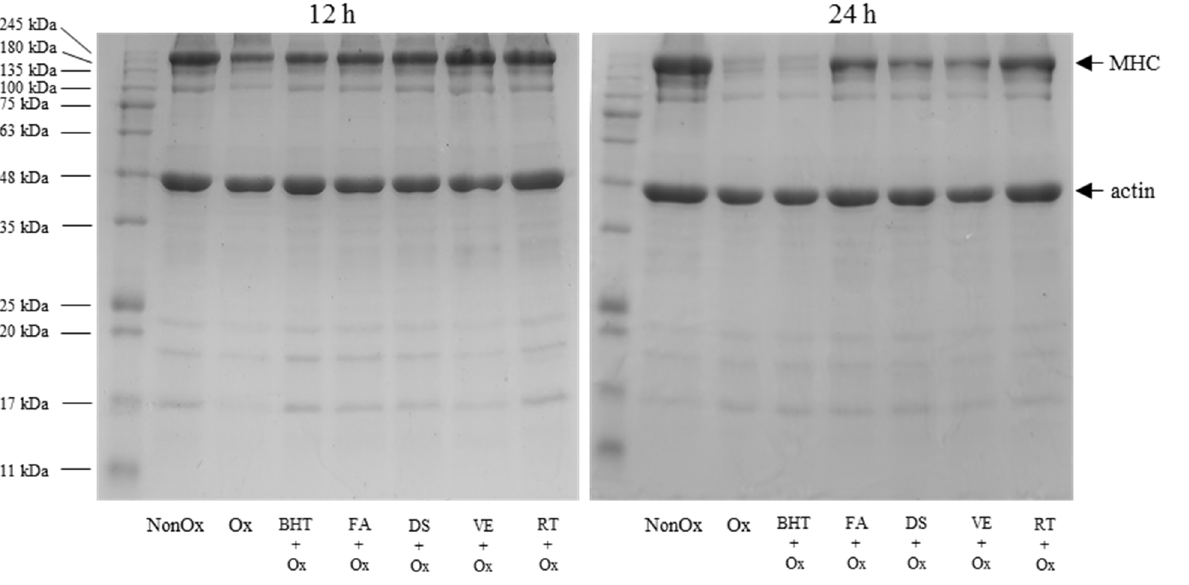
Figure 5. SDS-PAGE pattern of MPs in minced yak meat supplemented with different antioxidants. Note: NonOx—non-oxidized; Ox—oxidized without antioxidant; BHT + Ox, FA + Ox, DS + Ox, VE + Ox, and RT + Ox—oxidized in the presence of BHT, ferulic acid, diallyl sulfide, α -tocopherol, and rutin, respectively.